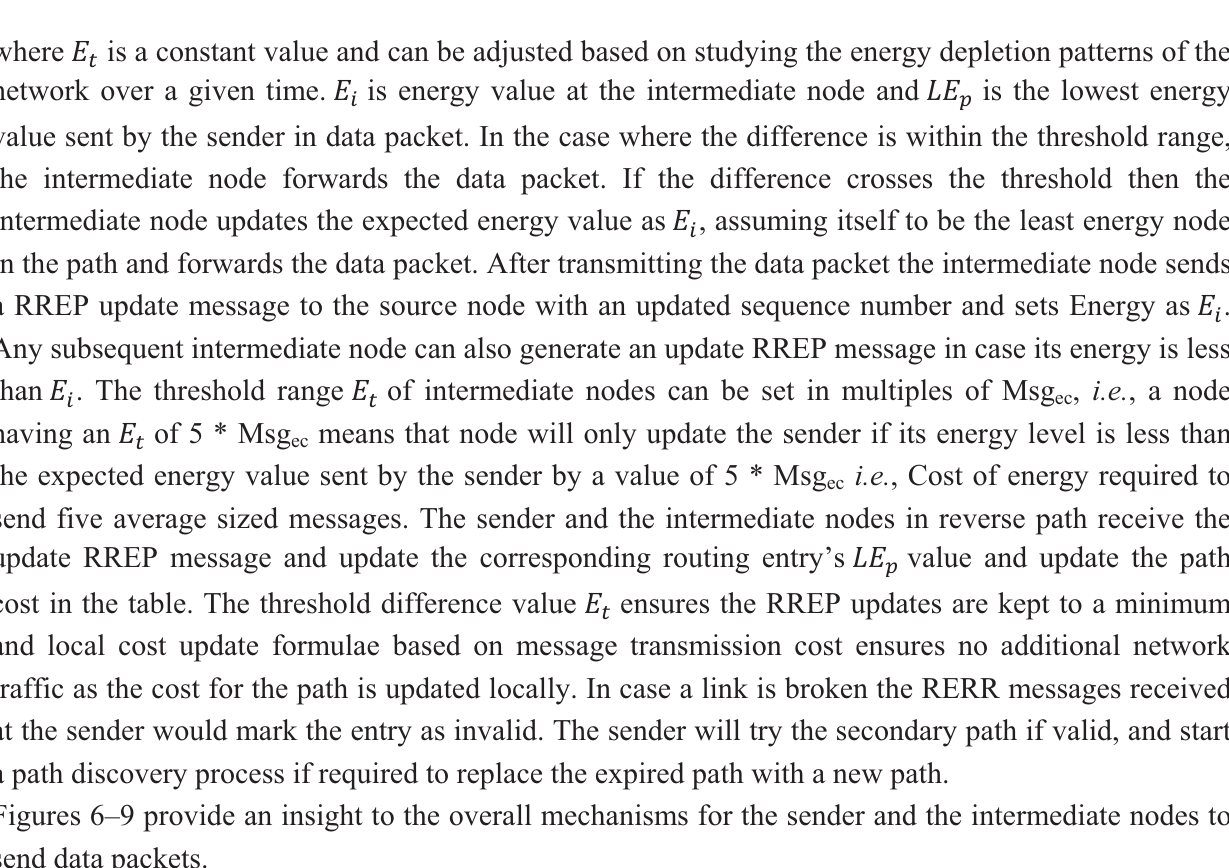
Figure 6. Algorithm to send data